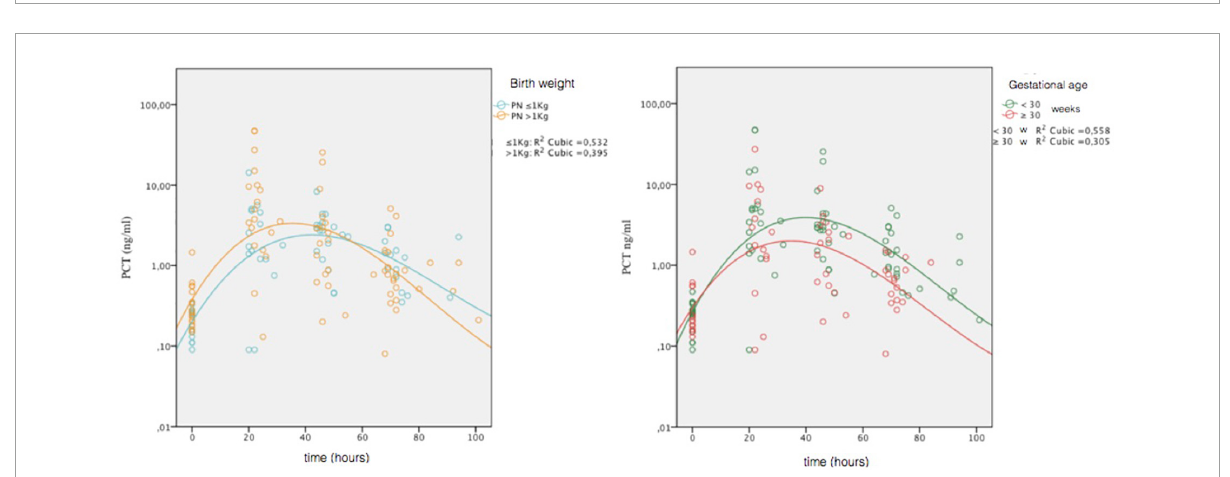
FIGURE3 Comparison of PCT values obtained in the four non-septic group (gestational age, ≥ 30 weeks and < 30 weeks; birth weight, > 1,000 and ≤ 1,000 g). Circles represent individual values; combined lines represent geometric mean. On the ordinate is the natural logarithmic scale of PCT